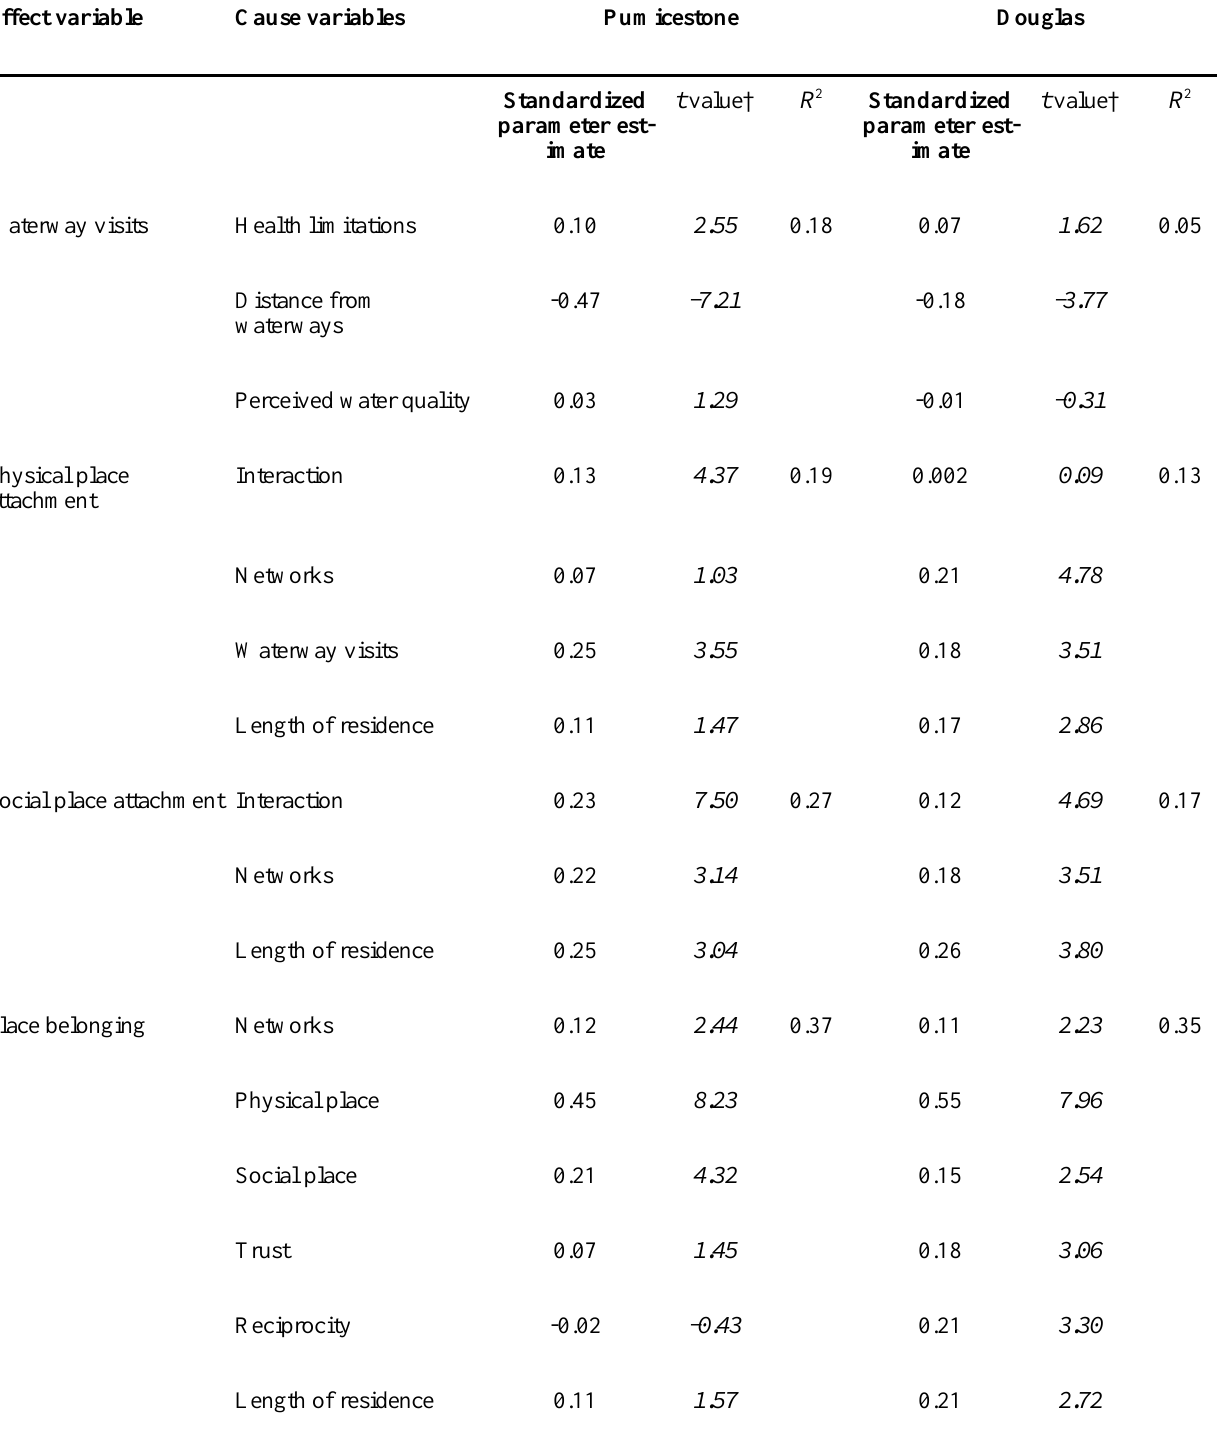
Table 5. Parameter estimates for the full path model for each